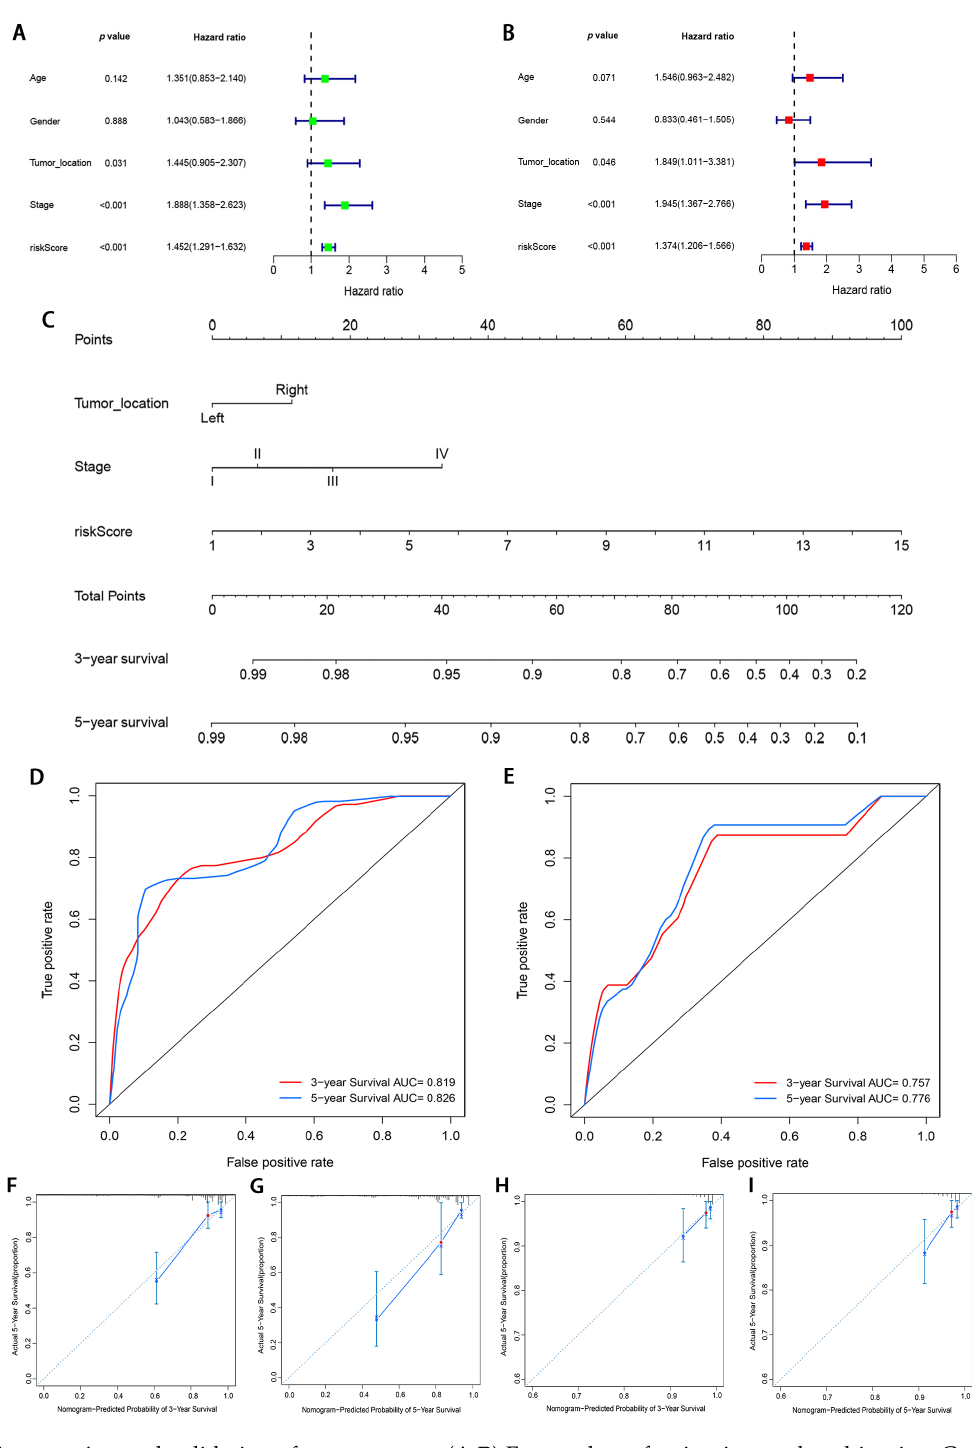
Figure 8. Construction and validation of a nomogram. ( A , B ) Forest plots of univariate and multivariate Cox regression analysis of variables associated with OS in the training cohort; ( C ) The nomogram for predicting the 3- and 5-year OS of CRC patients in the training cohort. ( D , E ) ROC curves for predicting the 3- and 5-year ROC curves in the training cohort ( D ) and validation cohort ( E ). ( F – I ) Calibration curves of the nomogram for predicting of 3- and 5-year OS in the training cohort ( F , G ) and validation cohort ( H , I